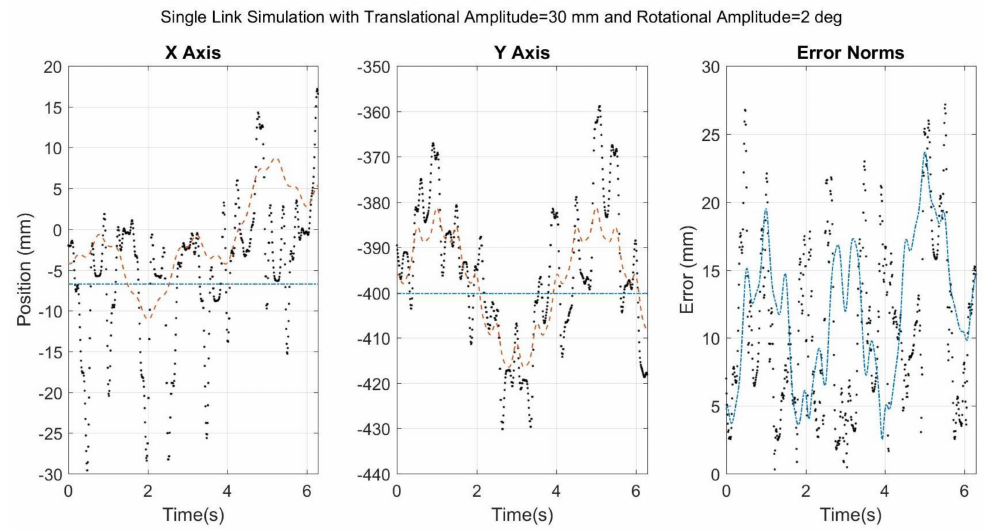
Figure 11. The same results as presented in Figure 10, but without frequency or moving average filtering applied to the SFO results. Black dots refer to SFO, blue dash-dots to SOM, and red dashes to the